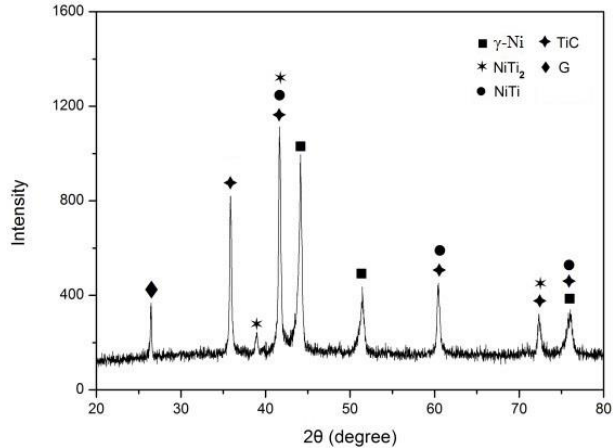
Figure 1. X-ray diffraction pattern of the coating.